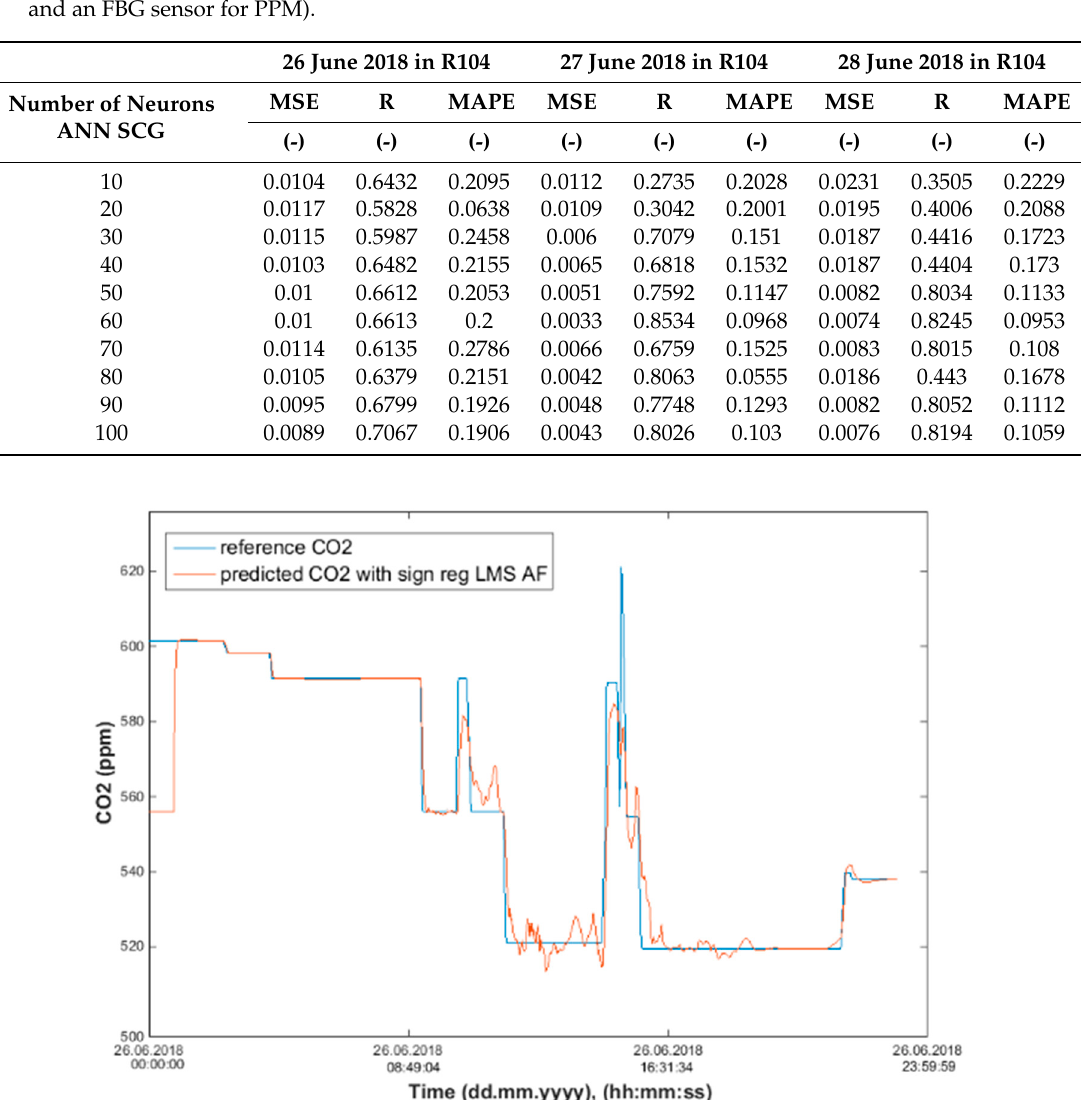
Figure 26. Comparison of the reference and predicted CO 2 waveforms (SRLMS AF) from 26 June 2018 in R203 with an ANN with 60 neurons and SCG method trained with data from 25 June 2018 in R203.